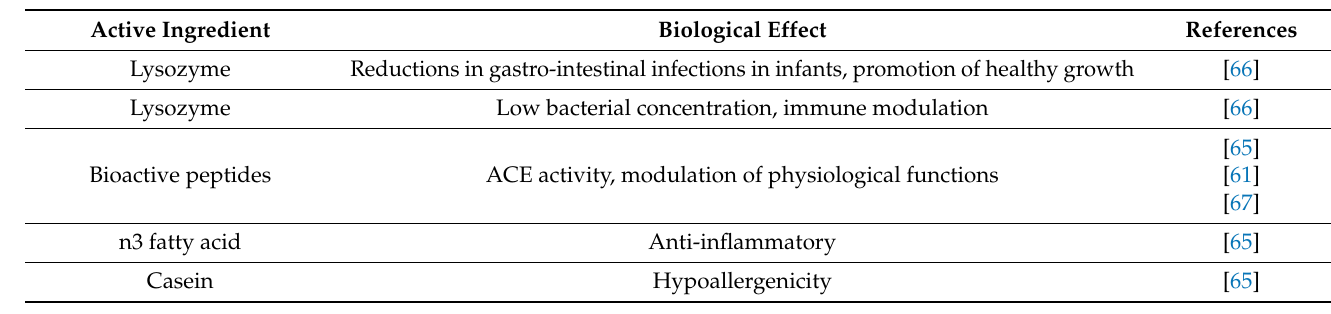
Table 4. Functional properties of donkey